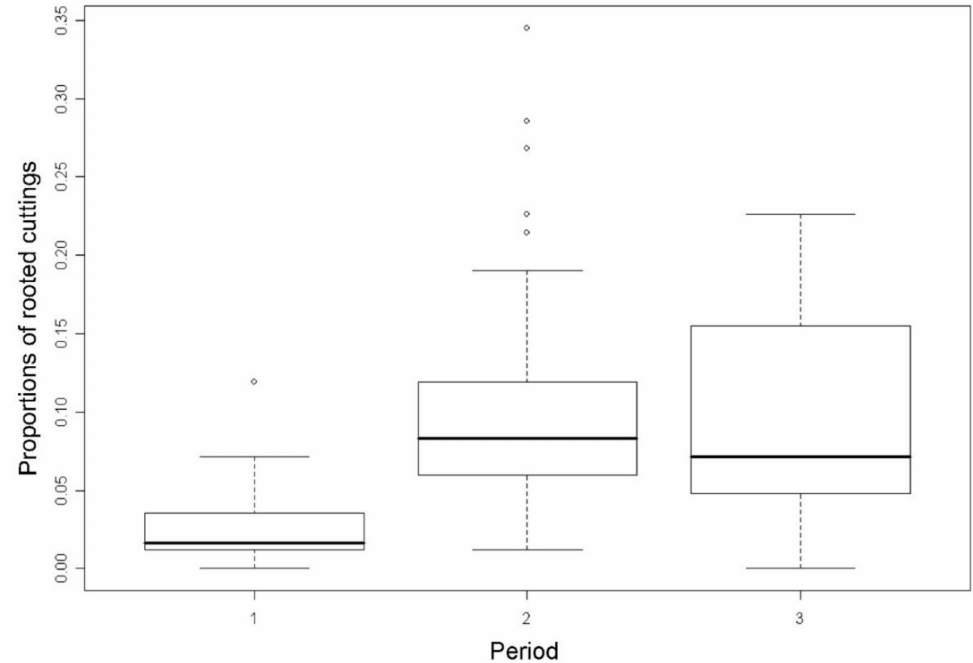
Figure 3. Box plot of the proportion of rooted cuttings from the total number of cuttings in relation to the cutting collection date. The horizontal line in each box represents the median, the hinges represent the 25th and 75th percentiles, the whiskers represent 1.5 times the interquartile range and open circles represent values outside this interval.